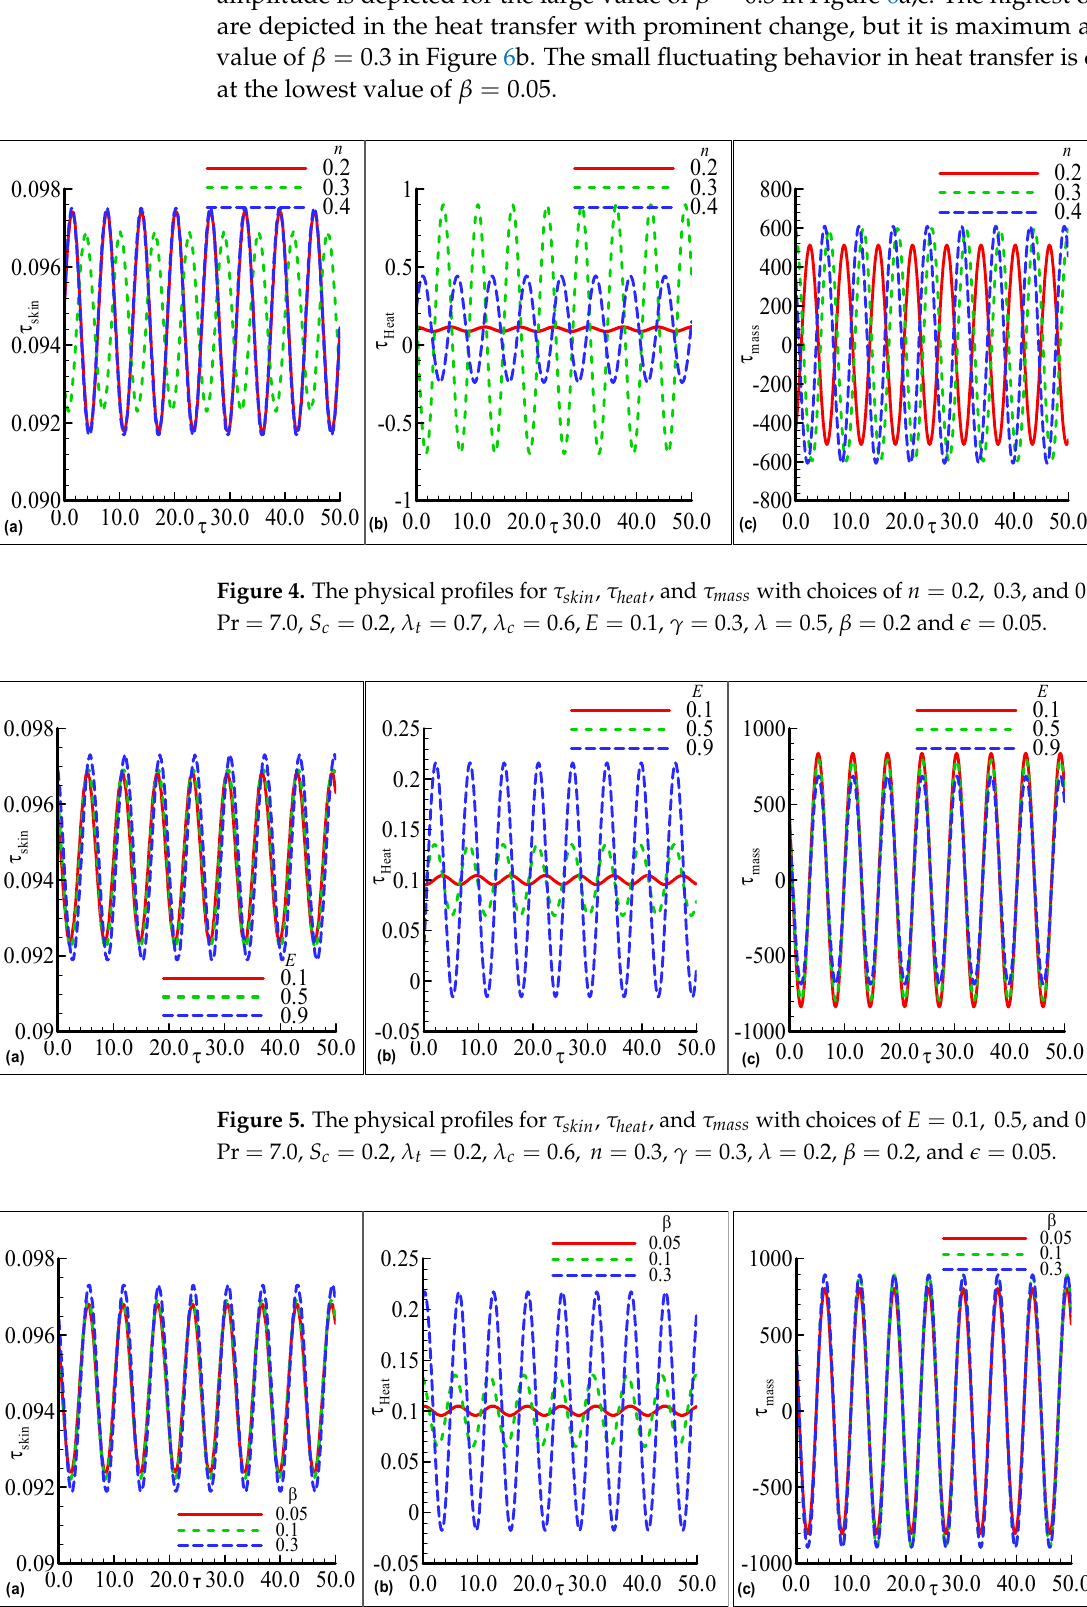
10 of 15 Figure 3. The physical profiles for 𝜏 (cid:3046)(cid:3038)(cid:3036)(cid:3041) , 𝜏 (cid:3035)(cid:3032)(cid:3028)(cid:3047), and 𝜏 (cid:3040)(cid:3028)(cid:3046)(cid:3046) with choices of 𝜆 (cid:3030) (cid:3404) 0.1,0.5, and 0.7 and fixed Pr (cid:3404) 7.0 , 𝑆 (cid:3030) (cid:3404) 0.2 , 𝜆 (cid:3047) (cid:3404) 0.5 , 𝐸 (cid:3404) 0.1 , 𝛾 (cid:3404) 0.3 , 𝜆 (cid:3404) 0.5 , 𝛽 (cid:3404) 0.2 , 𝑛 (cid:3404) 0.3 , and 𝜖 (cid:3404) 0.05 . Figure4a–c demonstrates the maximum fluctuations in each profile for every value of the index parameter 𝑛 (cid:3404) 0.2, 0.3, and 0.4 with the prominent distribution. The maximum amplitude is observed for two choices of 𝑛 (cid:3404) 0.2 and 0.4 uniformly but small oscillations in the skin friction arenoted at 𝑛 (cid:3404) 0.3 in Figure 4a. In Figure 4b, the large amplitude in the heat transfer with a certain height is examined at 𝑛 (cid:3404) 0.3 but a small oscillation is computed at lower 𝑛 (cid:3404) 0.2 . In Figure 4c, the prominent fluctuating response in mass transfer with good variations at each value of the index parameter 𝑛 is noted but is maximum for the largest value 𝑛 (cid:3404) 0.4 . The oscillating 𝜏 (cid:3046)(cid:3038)(cid:3036)(cid:3041) , 𝜏 (cid:3035)(cid:3032)(cid:3028)(cid:3047), and 𝜏 (cid:3040)(cid:3028)(cid:3046)(cid:3046) for three choices of the activation energy parameter 𝐸 (cid:3404) 0.1, 0.5 and 0.9 are